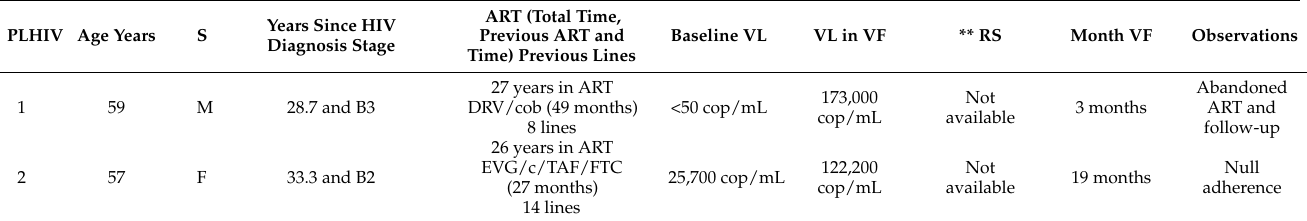
Table 3. Virological failure.